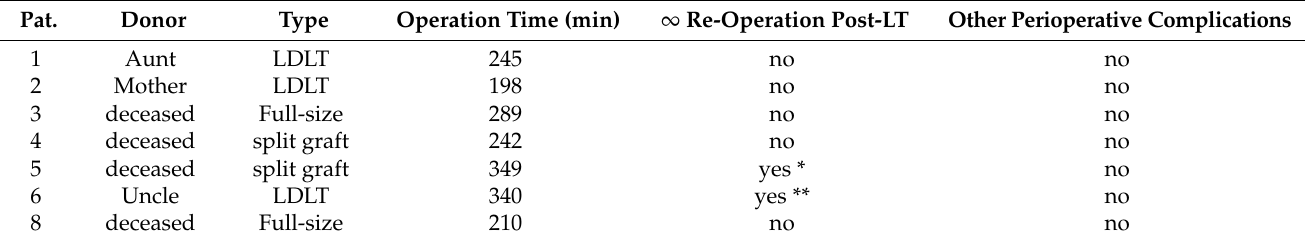
Table 3. Donor characteristics, perioperative parameters.